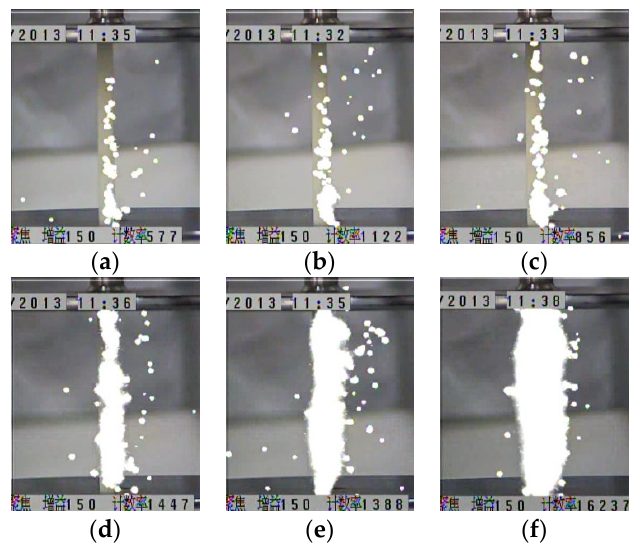
Figure 5. Streamer propagation photographs for the polymer. ( a ) 500 kV/m, ( b ) 530 kV/m, ( c ) 550 kV/m ( d ) 590 kV/m, ( e ) 620 kV/m, ( f ) 660 kV/m.